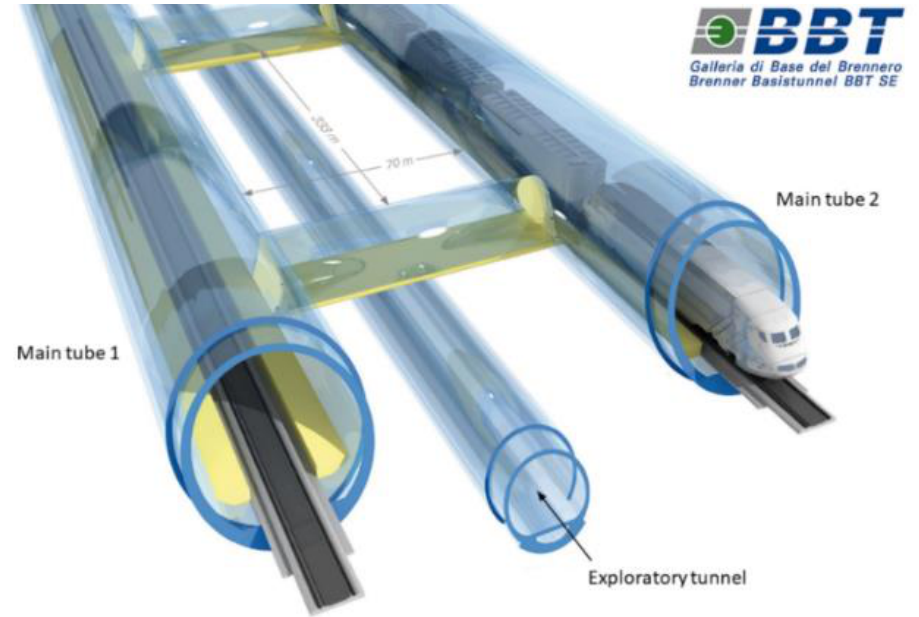
Figure 3. Sketch of the BBT cross section, modified from [21].